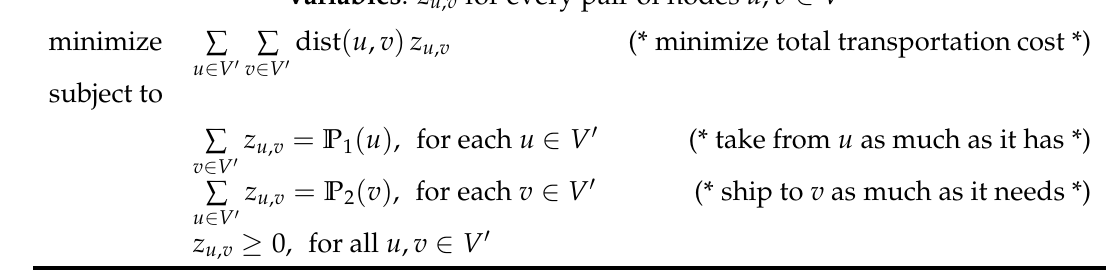
2 variables. Comments are enclosed V (cid:48) V (cid:48) with | | | | 1 are unnecessary and therefore ≤